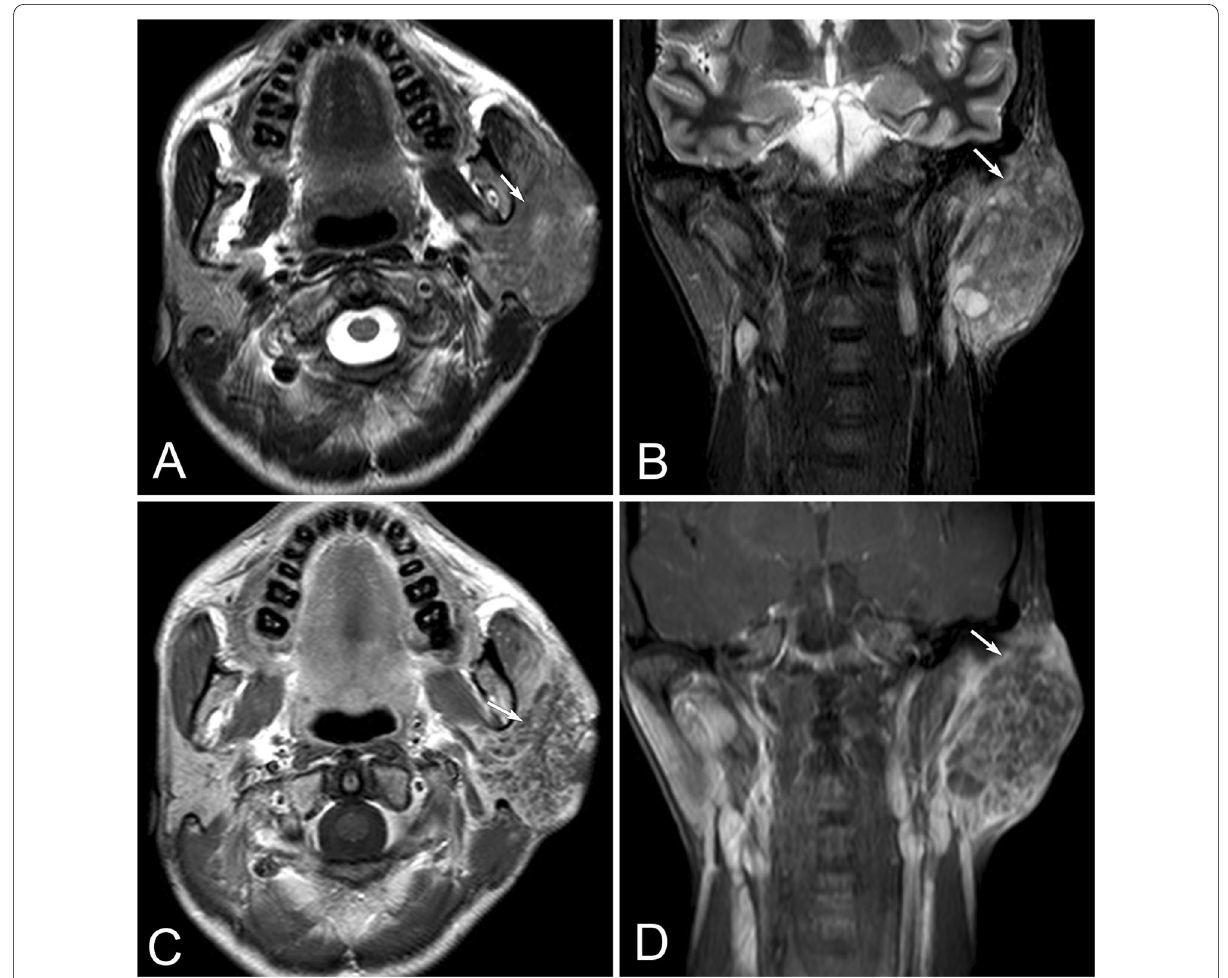
Fig. 2 A 37 years old female with primary parotid SCC in the left parotid gland. Axial T2WI ( A ) and coronal T2WI ( B ) show an ill-defined, irregular mass in the left parotid gland. The tumor is slightly hypointense with multiple small focal areas of obvious hyperintensity on T2WI (arrow). Contrast-enhanced axial ( C ) and coronal ( D ) T1WI show obvious heterogeneous enhancement with multiple small focal areas of necrosis